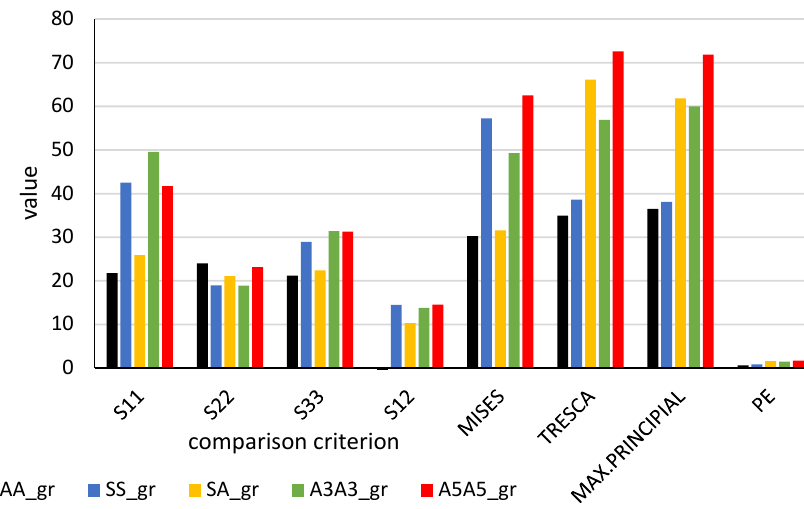
Figure 28. Comparison of maximal values of the potential failure criteria for the analysed types of joints (results for adhesive–element boundary layer).